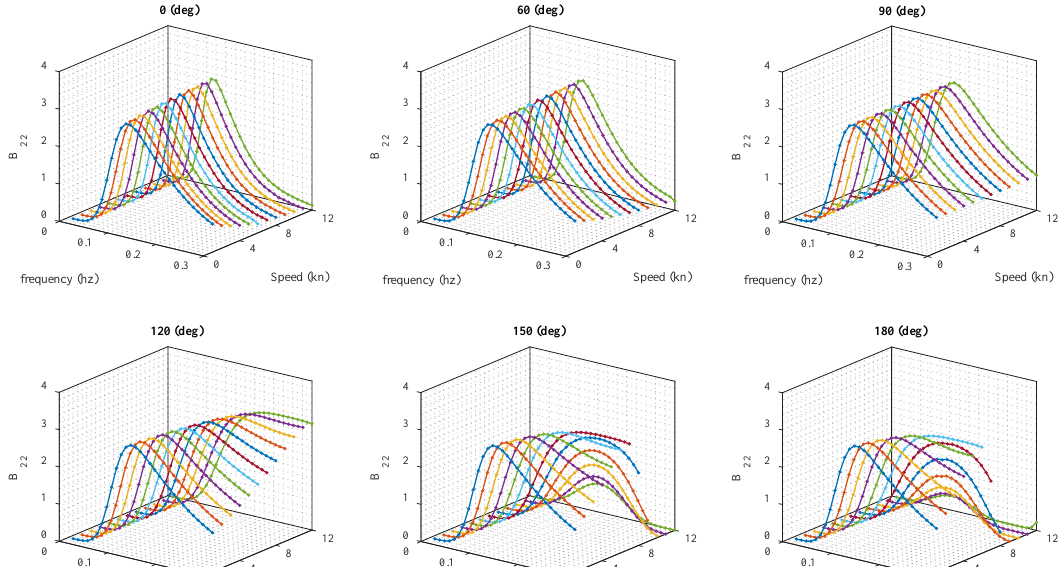
Figure 20. Motion RAO (heave).